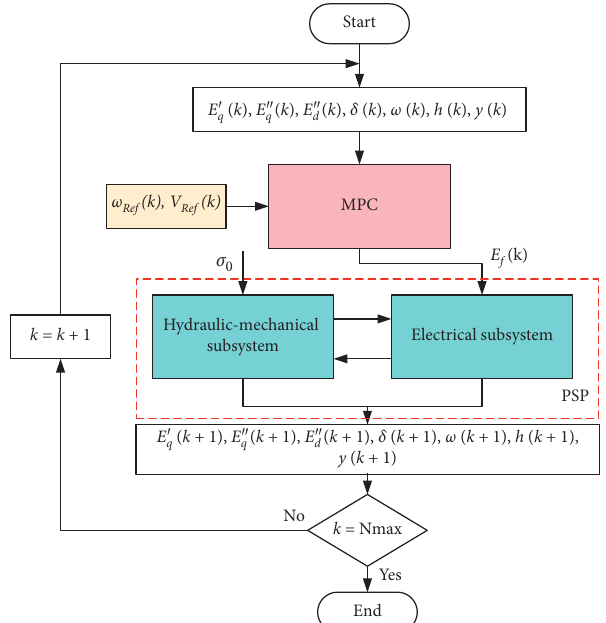
Figure 18: Flow charts of noncoupling MPC strategy.